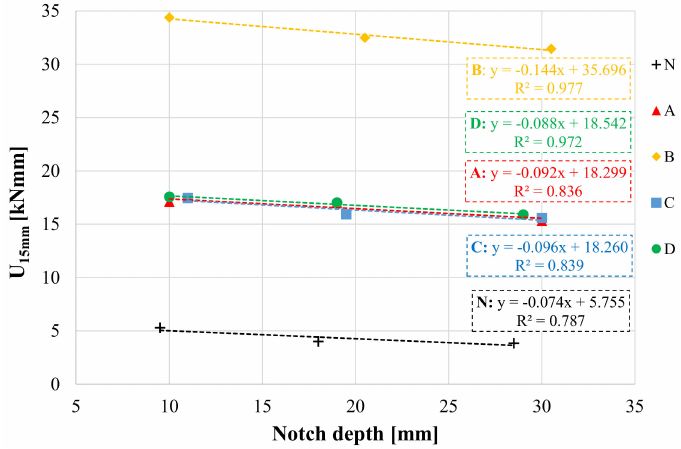
Figure 9. Strain energy U calculated until a deflection of 15 mm for different notch depths and different interface configurations.